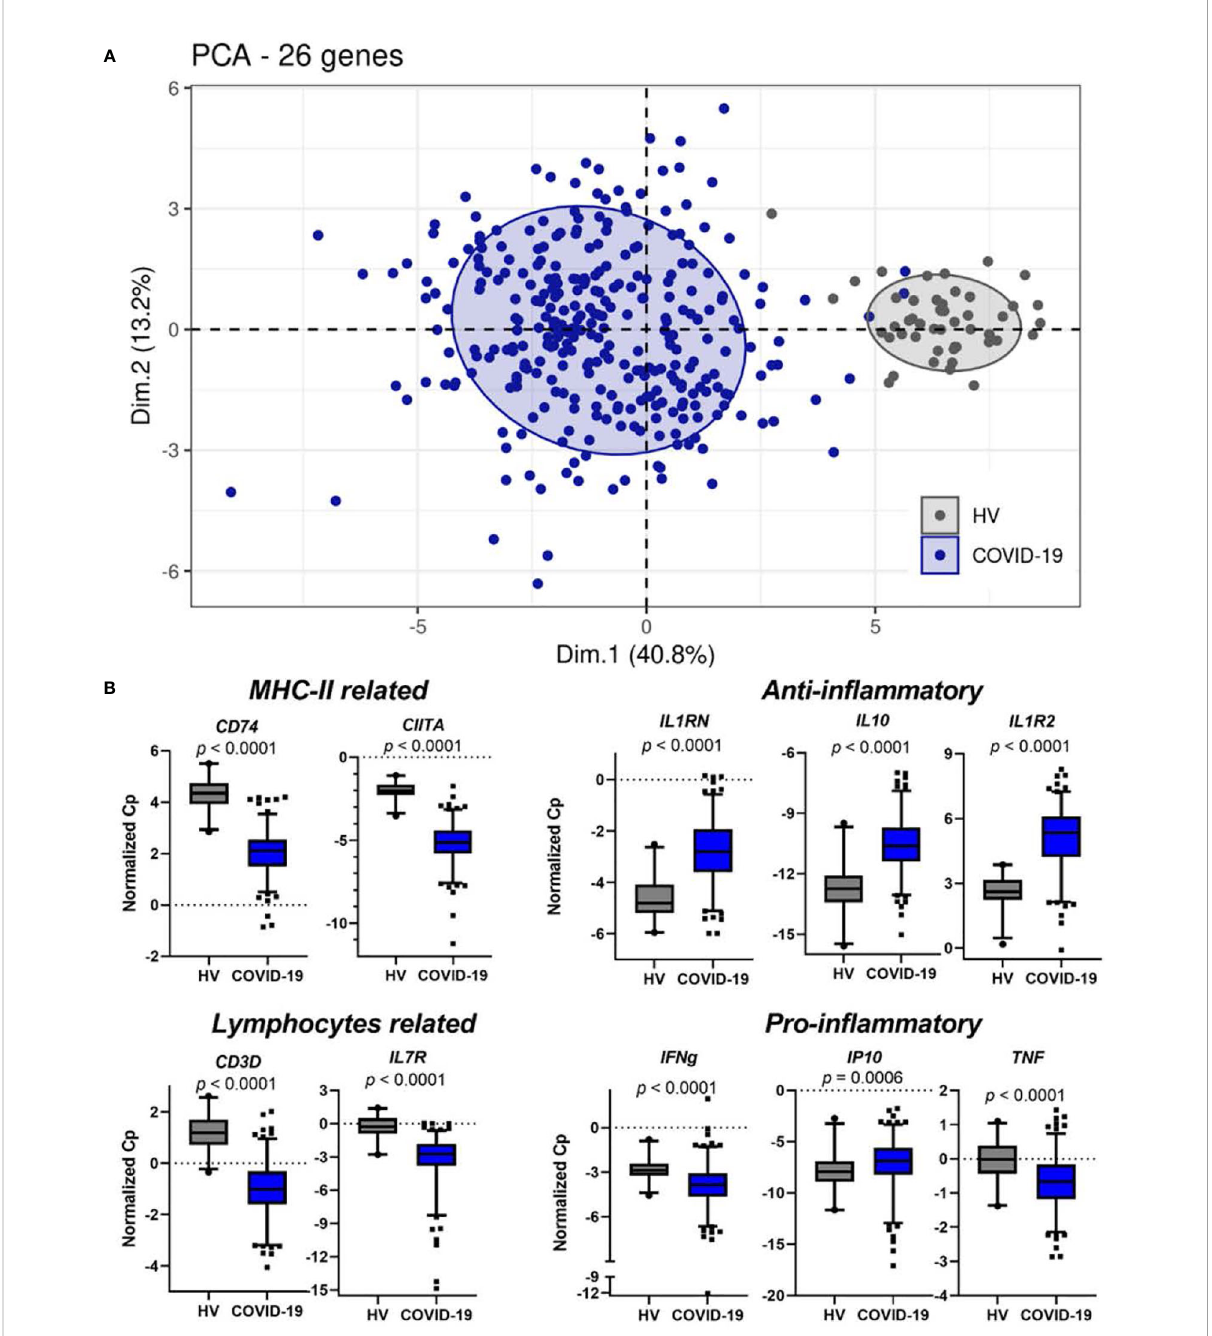
FIGURE 1 IPPmarkersdistinguishhealthydonorsfromcriticallyillCOVID-19patientsandareassociatedwithimmunologicalparameters. (A) Non-supervisedPCAonIPP markersmeasuredatadmission(Day0)incriticallyillCOVID-19patients(n=309)andhealthydonors(n=49). (B) Boxplotsrepresentationoftheexpressionof